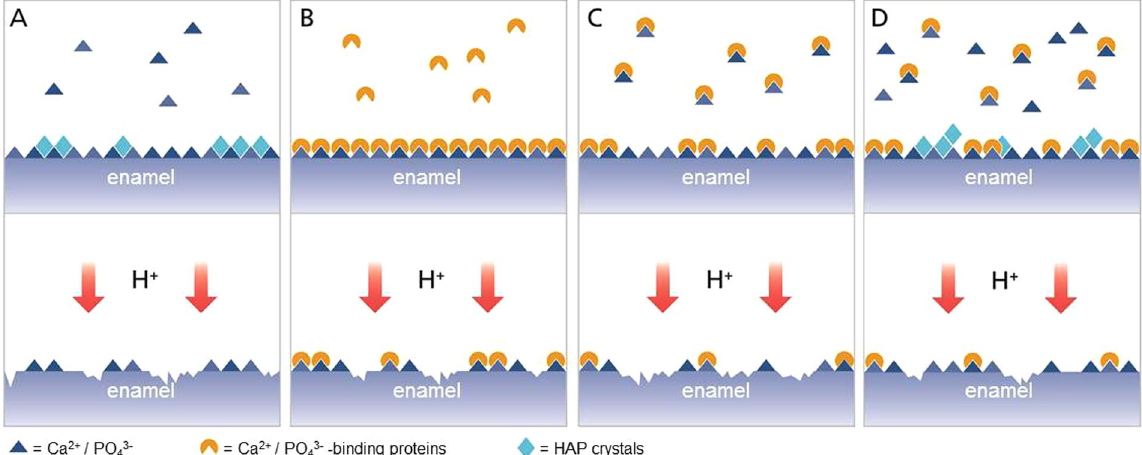
Figure 5. Model of protection of the enamel surface from erosion by different types of saliva. ( A) Artificial saliva without proteins. (B) Dialysed saliva without ions. (C) Dialysed saliva with low ion concentrations. (D) Dialysed saliva with high ion